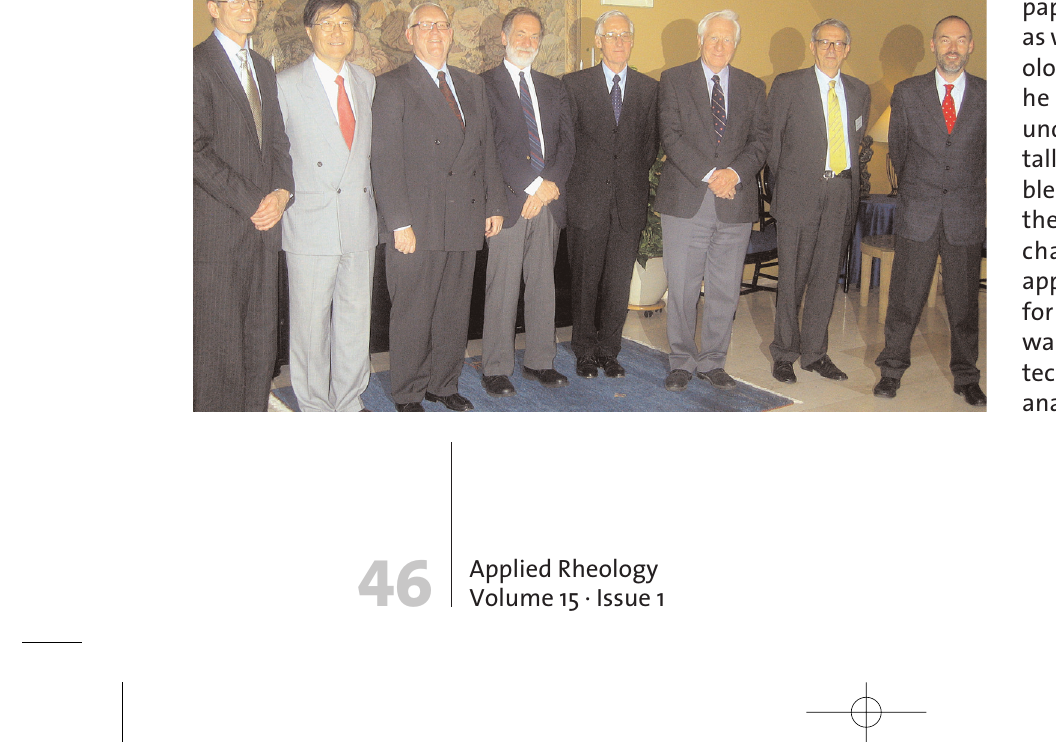
Figure 1: From left to right: W. Russel (Princeton Univer- sity), H. Masuhara (Osaka University), H.M. Laun